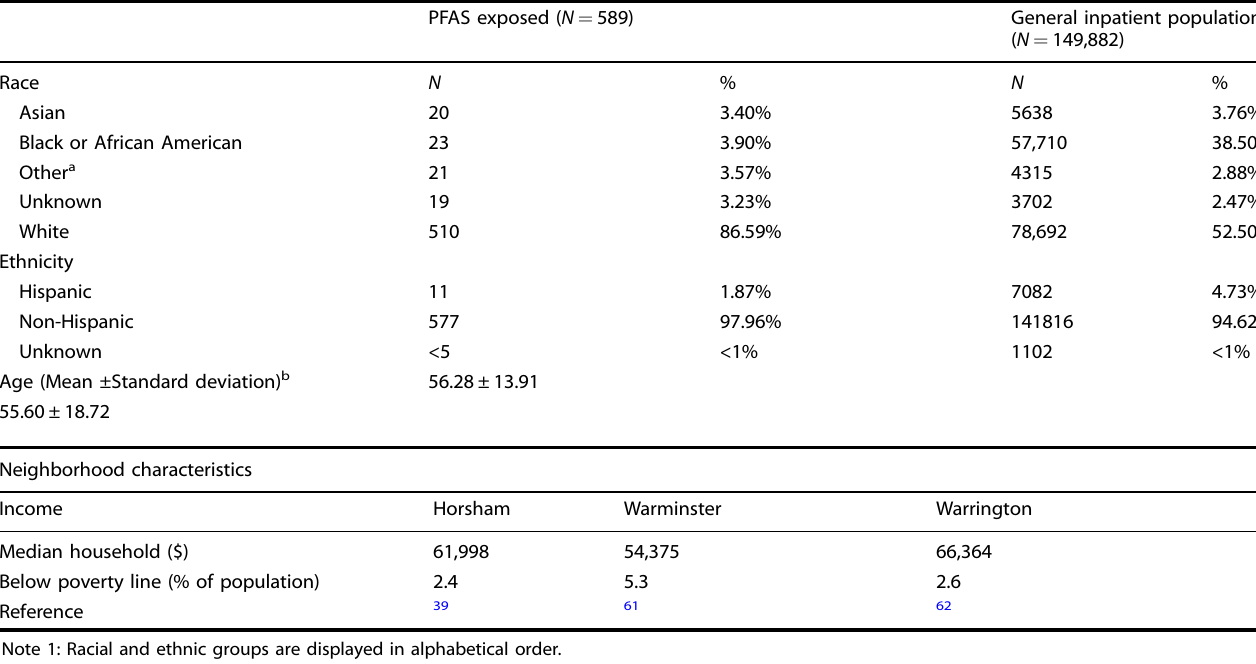
Table 1. Demographics of our PFAS exposed vs. general inpatient population used in this